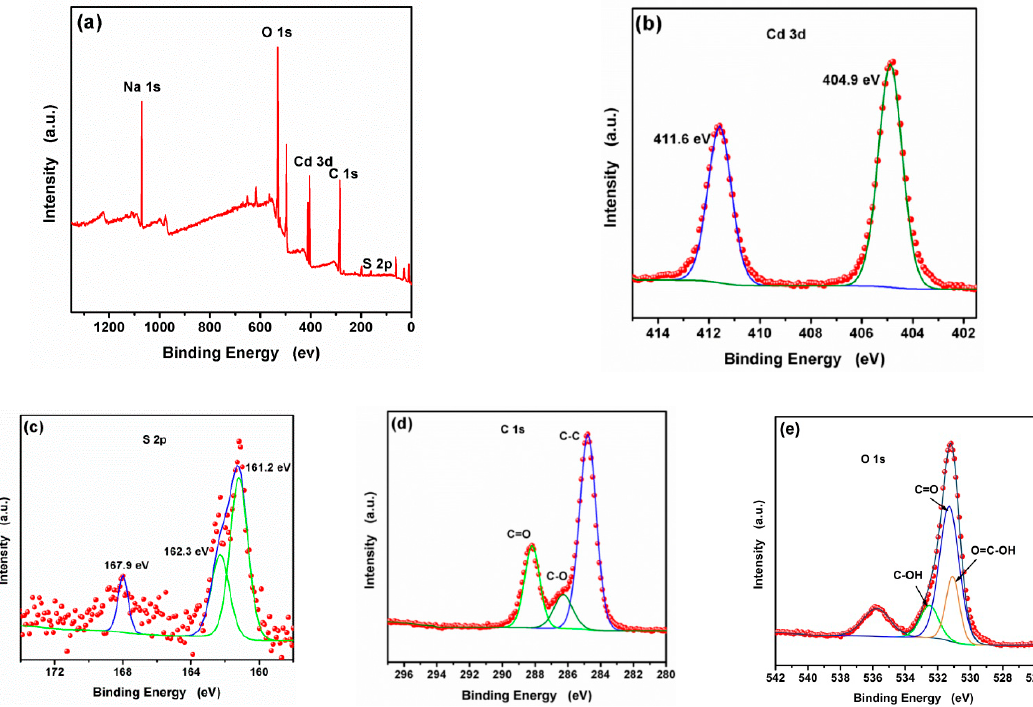
Figure 2. The ( a ) survey, ( b ) Cd 3d, ( c ) S 2p, ( d ) C 1s and ( e ) O 1s XPS spectra of the CA-CdS QDs.